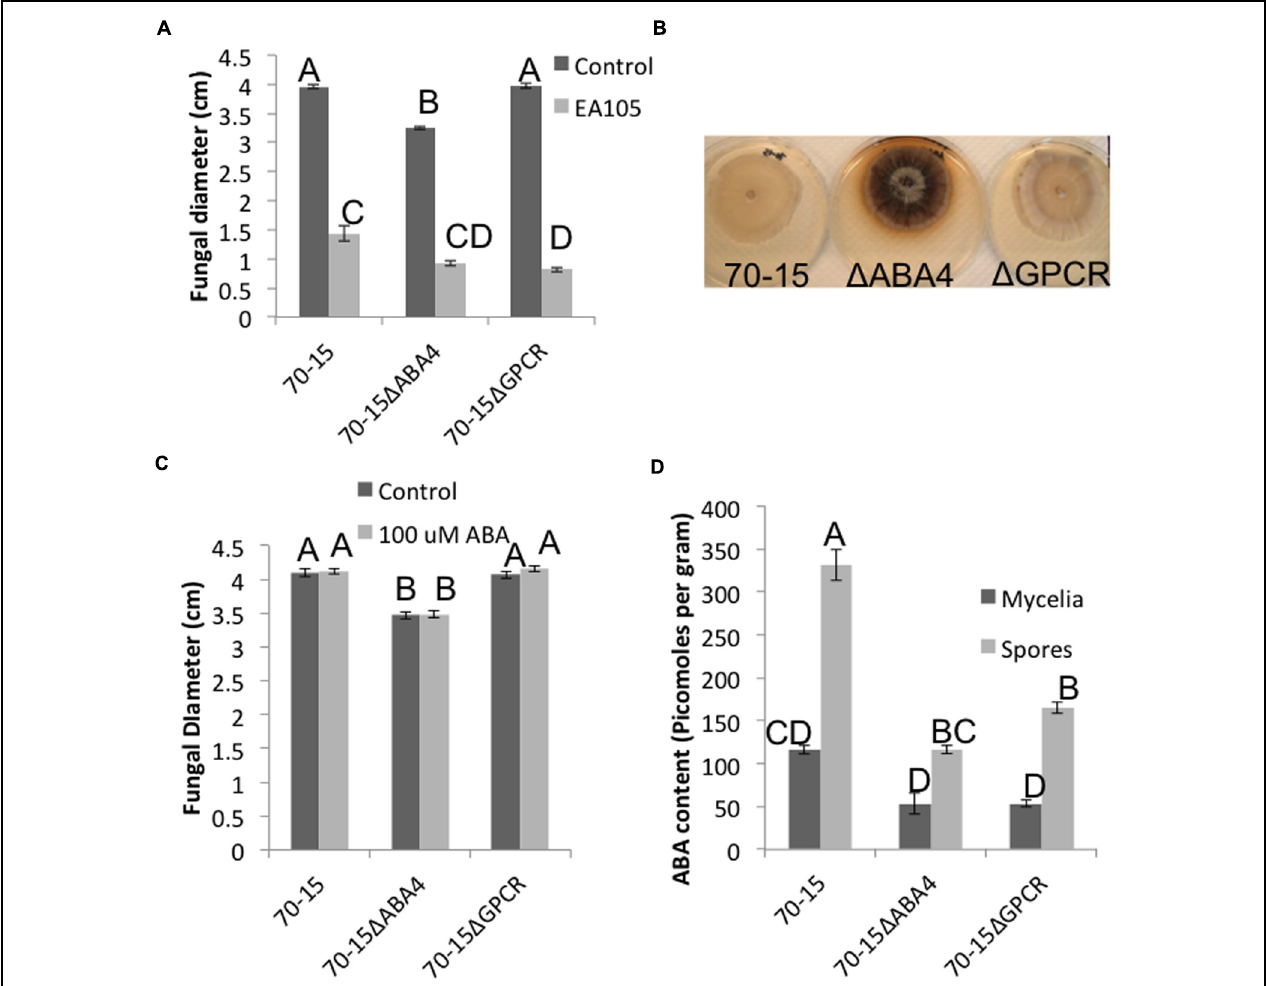
FIGURE 5 | Vegetative growth characteristics of ABA4 and ABA GPCR knockout mutants. (A) Fungal diameter of 70-15, 70-15 (cid:2) ABA4, and 70-15 (cid:2) GPCR at 7 days after culturing, the in presence and absence of EA105. (B) At 14 days post culturing, 70-15 (cid:2) ABA4 looks strikingly different than its parental strain due to pigmentation. (C) Fungi were grown on CM amended with 100 μ M ABA and fungal diameters were measured after 7 days. (D) ABA content was quantified in spores and mycelia of 70-15 and the two mutants. Different letters represent statistical significance based on the Tukey-Kramer test ( p <